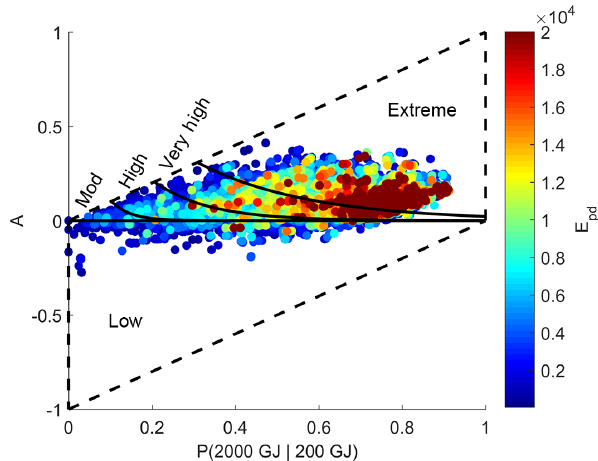
Figure 13. As in Fig. 3 but with respect to results for the calibration period (2004–2016) based on values of P( 2000 | 200 ) and respective anomalies A . Fire events during the period are superimposed, being represented by circles coloured according to the daily released en- ergy